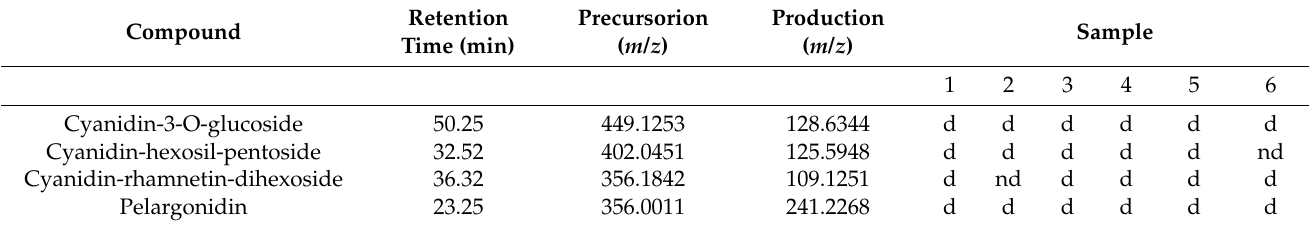
Table 4. Anthocyanins and anthocyanidins detected in extracts of defatted Willamette, Polka, and Meeker raspberry seeds, obtained using UAE under optimal conditions and after